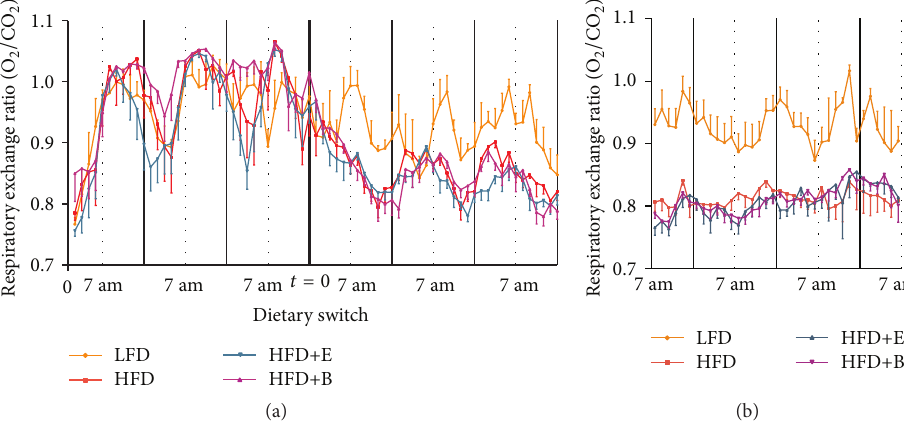
Figure 2: Metabolite utilization. Respiratory exchange ratio (RER; O 2 consumed/CO 2 produced) measured before and after dietary switch (a) and after 23 weeks (b) shows distinctive drop for all HFD groups in both the short and long term which is not enhanced by polyphenol supplementation.